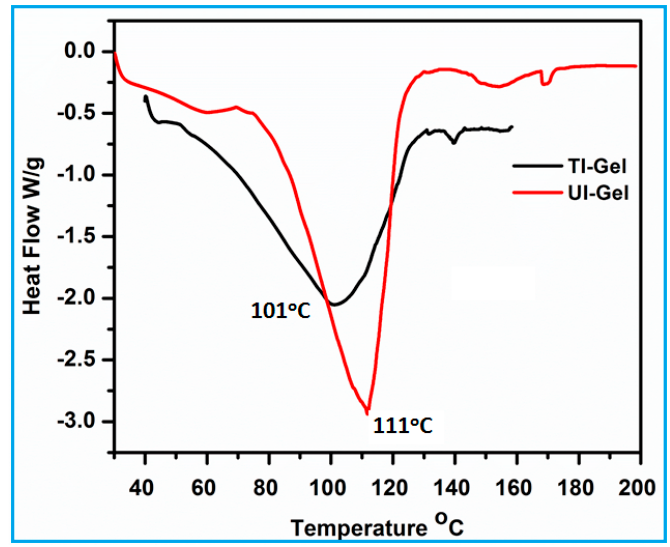
Figure 3. Thermogram of UI-gel and TI-gel in DMSO/water (80/20 v/v ) at 30 mg/mL concentration.